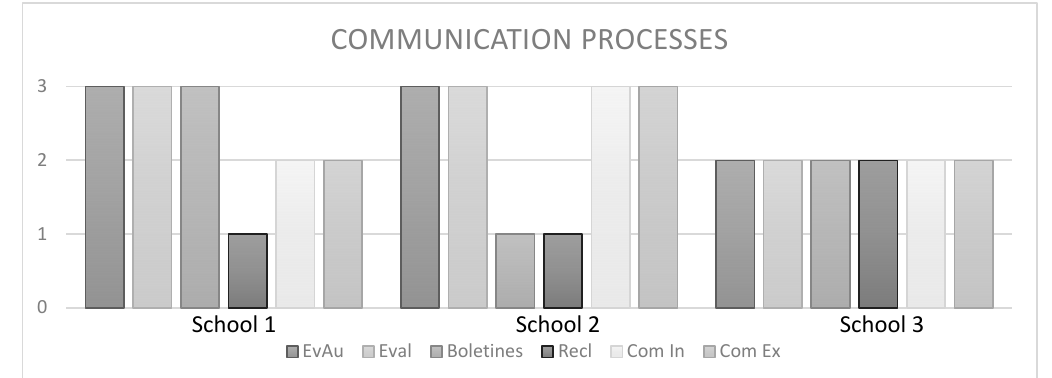
Figure 5. Communication Processes. Source: author.